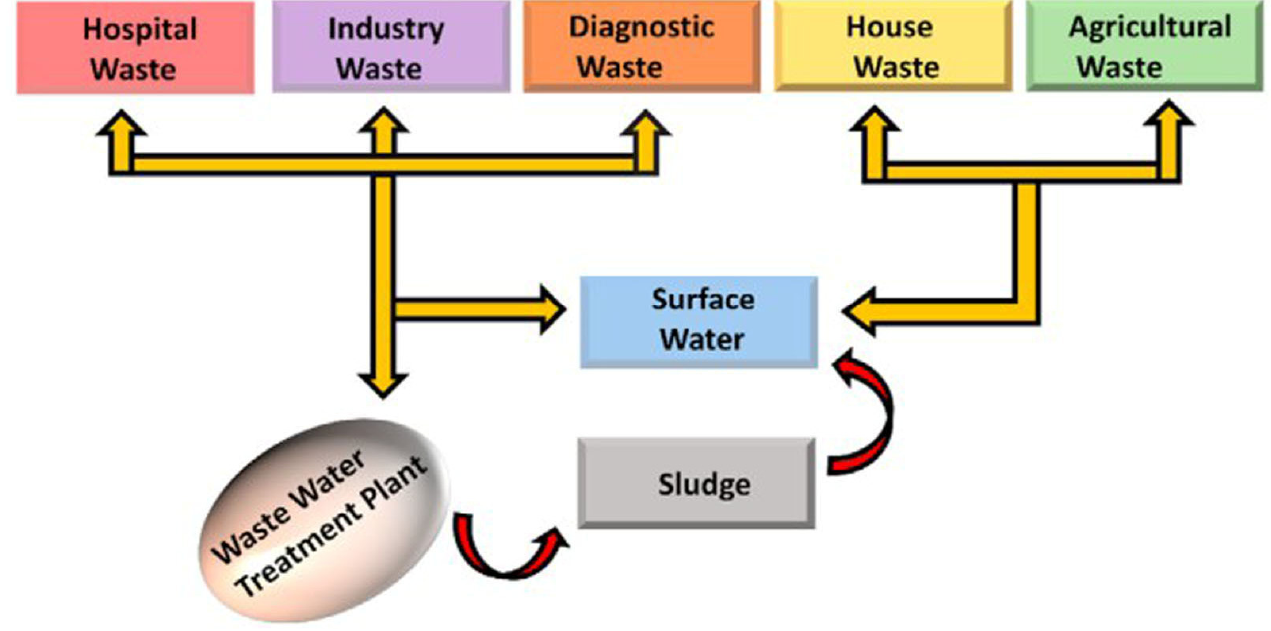
Figure 1. Sources of different emerging antibiotics pollutants in daily life. (Reproduced with per- mission from [19], copyright 2021,